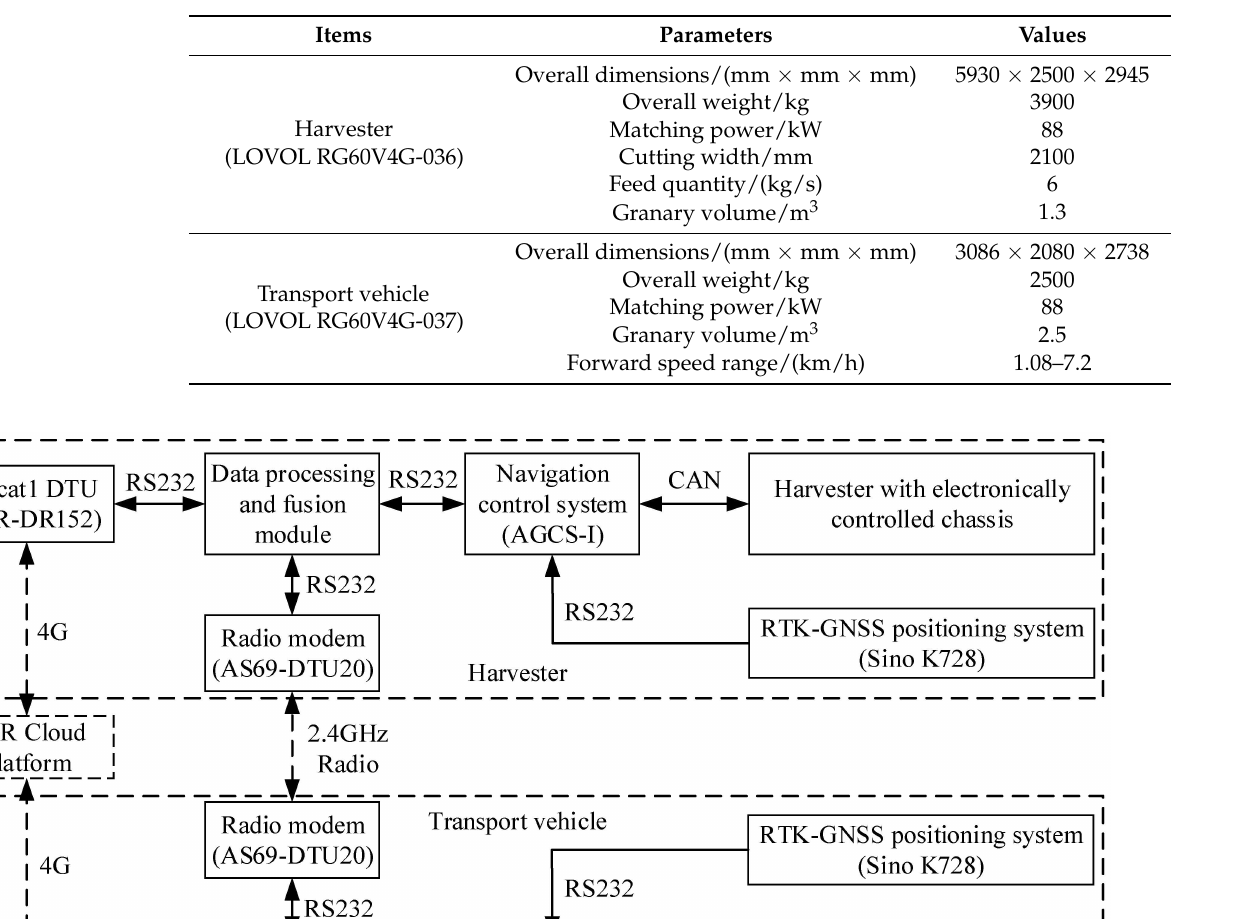
Table 3. Main structural parameters of the harvester and transport vehicle.